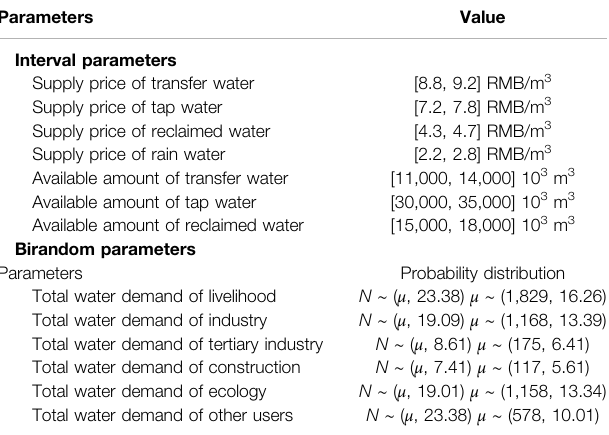
TABLE 3 | Parameters related to the water resource